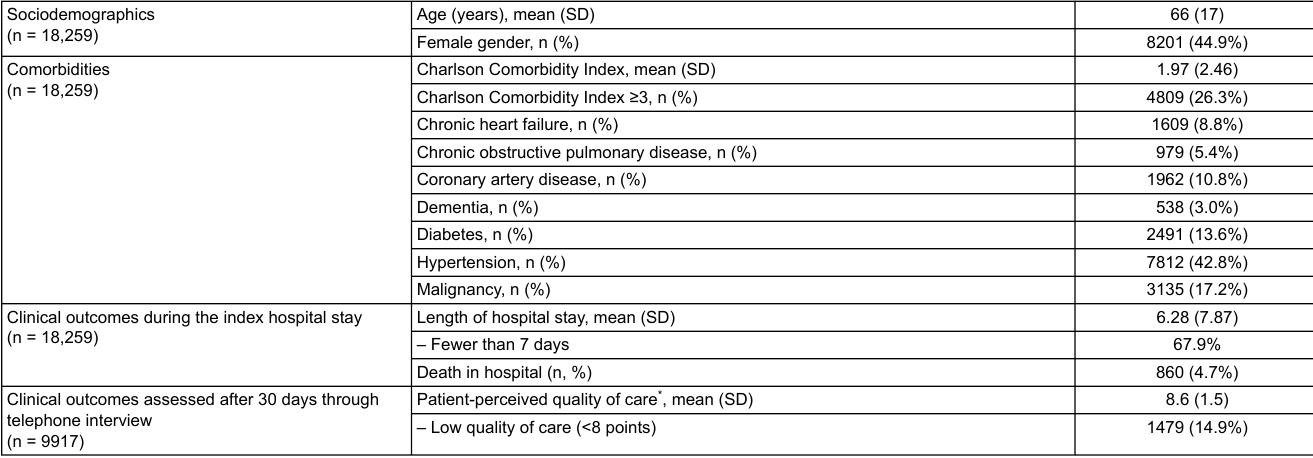
Table 1: Sociodemographics and outcomes of all patients in the study. Sociodemographics (n = 18,259)